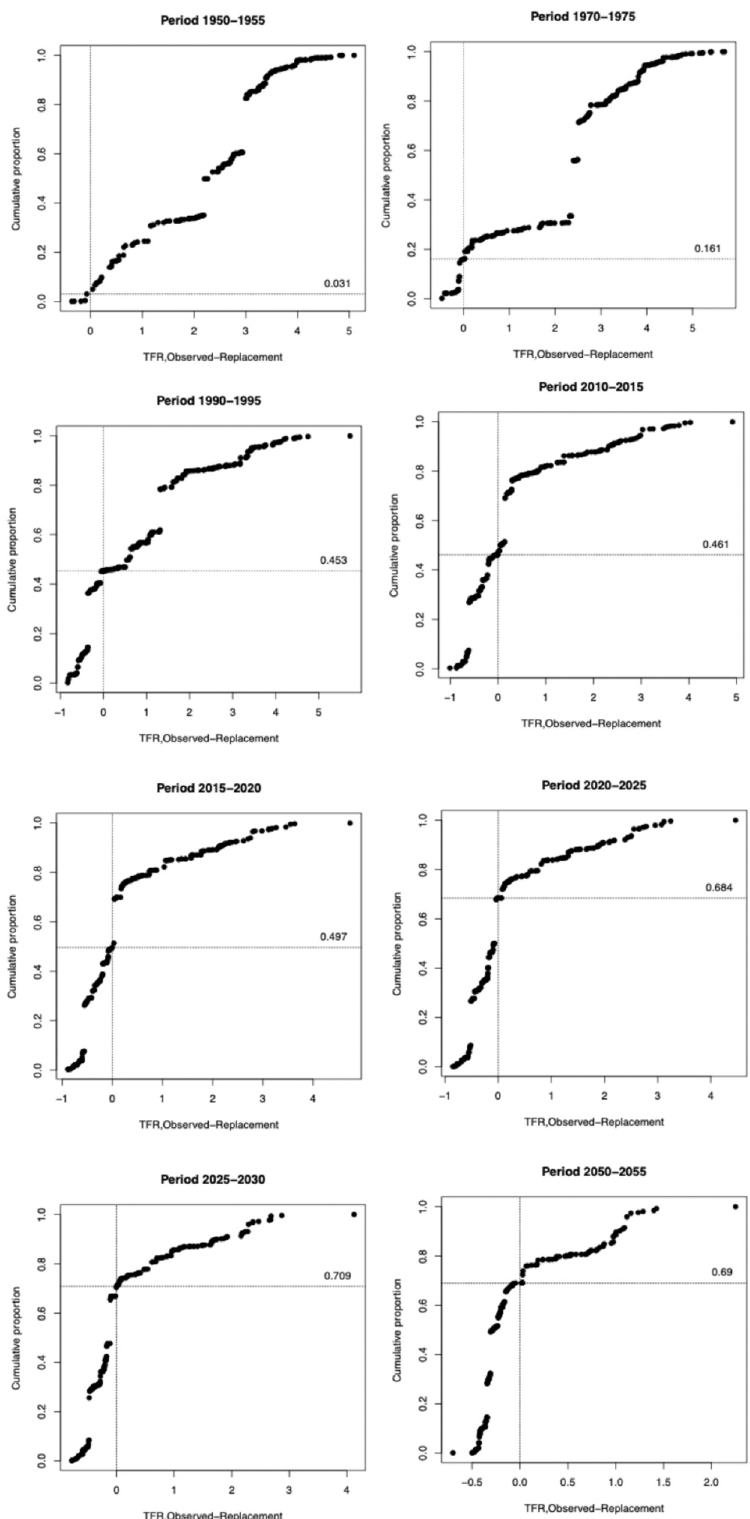
Fig 2. Cumulative proportion of global population (y-axis) of UN-specified territories ordered by observed TFR minus calculated RRF (x-axis) with proportion living in territories where observed TFR is equal or less than the point at which observed TFR = calculated RRF (intersecting line), selected years. https://doi.org/10.1371/journal.pone.0224985.g002 PLOS ONE | https://doi.org/10.1371/journal.pone.0224985 December2,